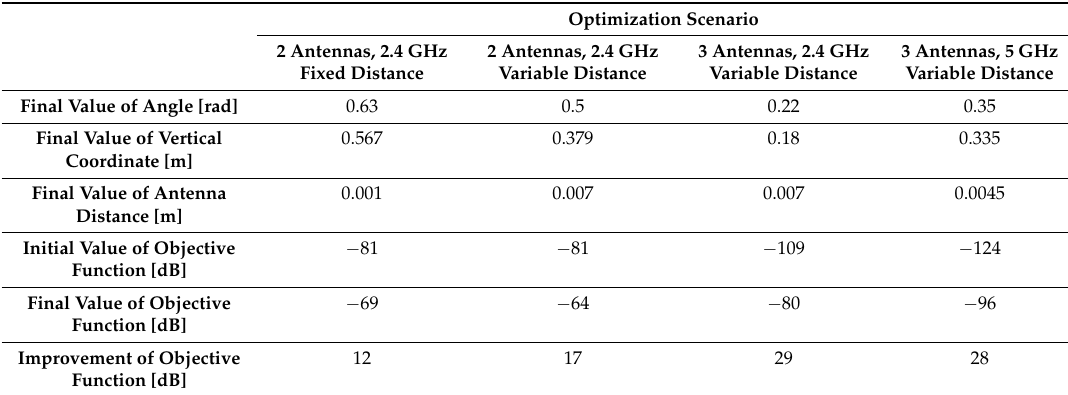
Figure 10. Scattering matrix parameter values vs. frequency before and after optimization for 5.8 GHz frequency band. Table 1. Optimization with the evolution strategy algorithm.